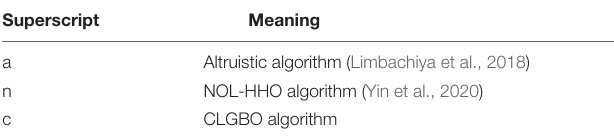
TABLE 9 | Meaning of superscript.